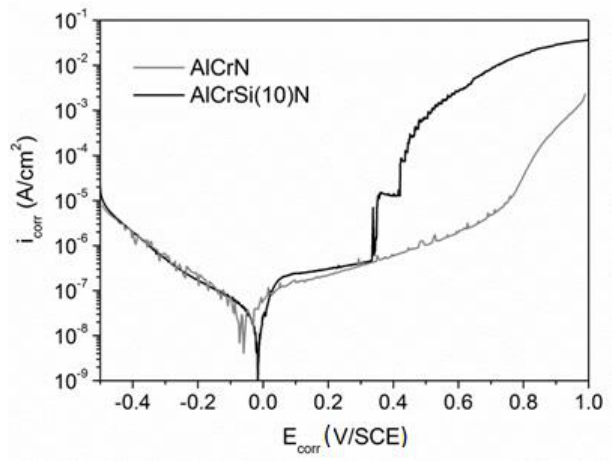
Figure 15. Results of the potentiodynamic polarization tests obtained for the HS6-5-2 / AlCrSi(10)N and HS6-5-2 / AlCrN systems.